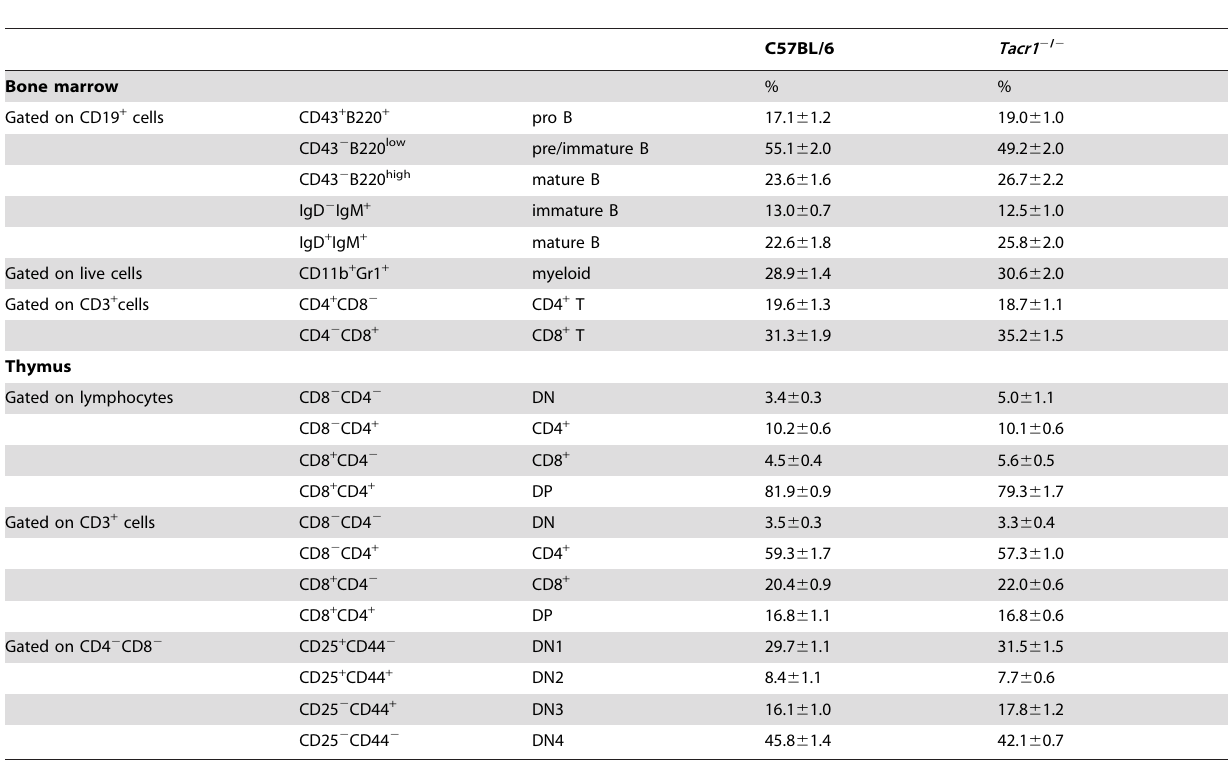
Table 1. Flow cytometry analysis of bone marrow and thymus of C57BL/6 and Tacr1 2 / 2 mice.